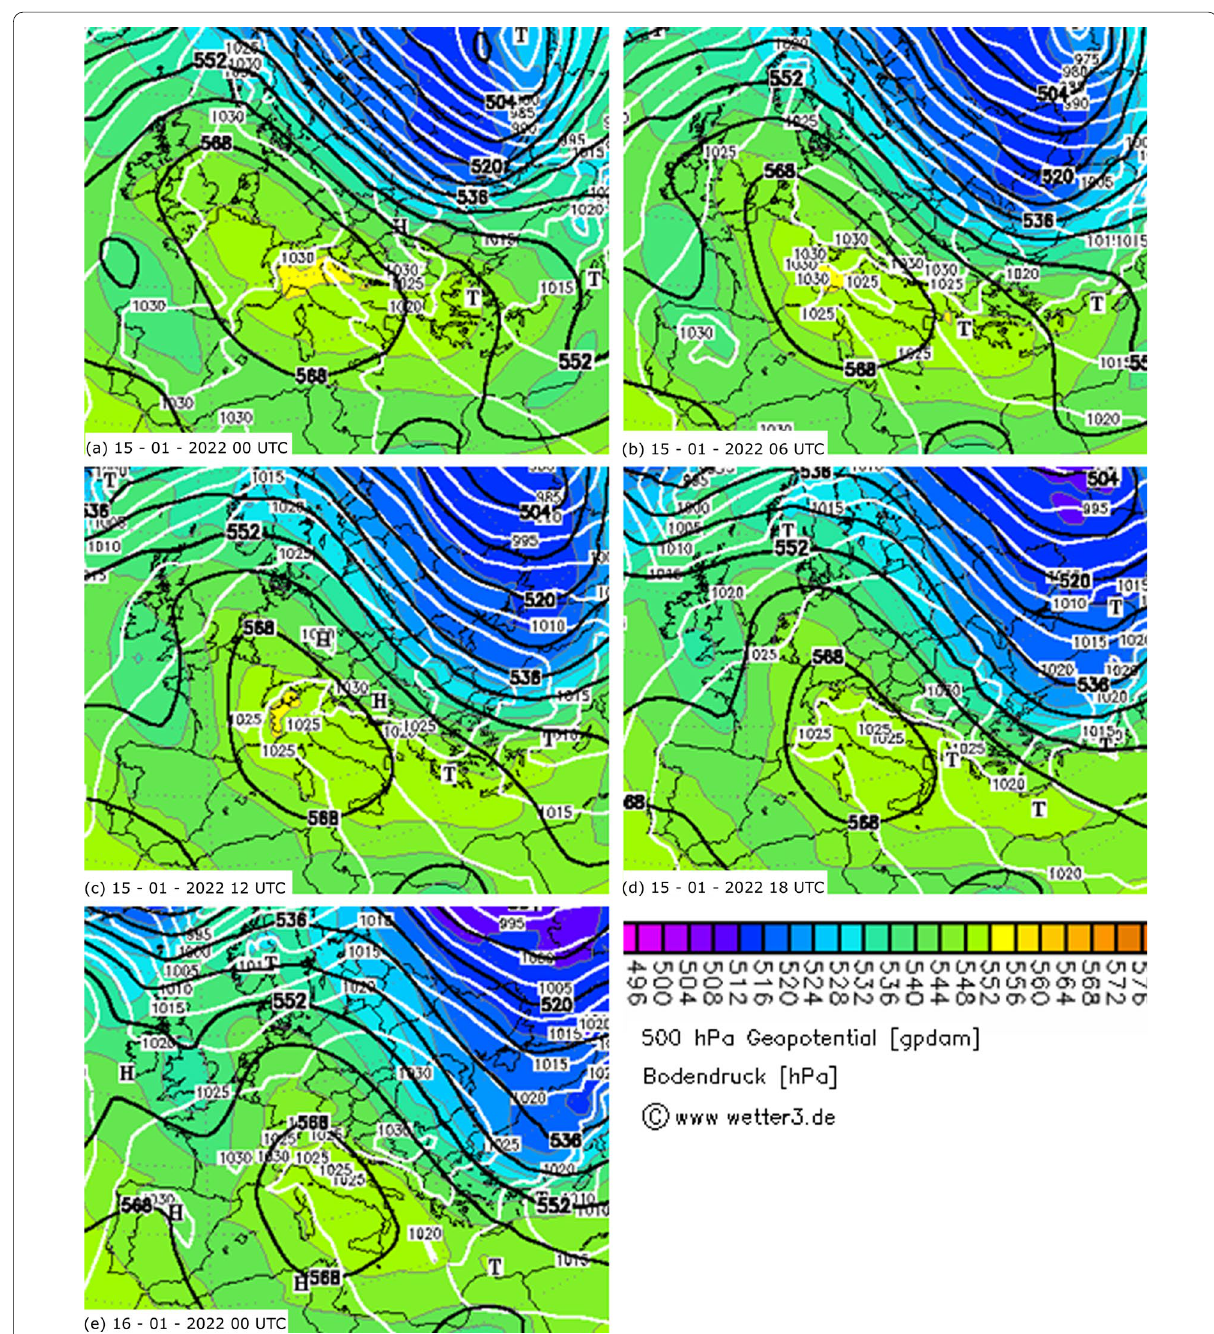
Fig. 4 Upper-level structure of the atmosphere (500 hPa geopotential/temperature maps) on January 15, 2022: 00 UTC ( a ), 06 UTC ( b ), 12 UTC ( c ), 18 UTC ( d ) and on January 16, at 00 UTC ( e